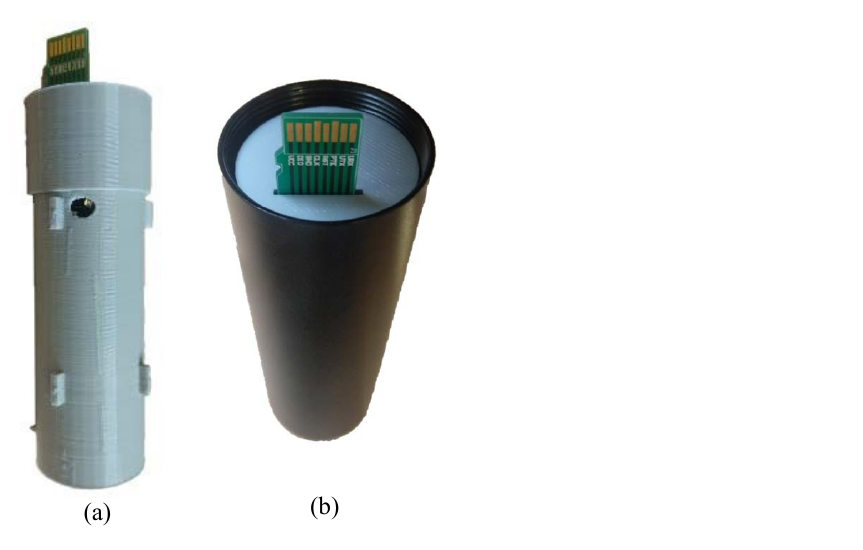
Figure 11. Underwater sensor node construction details: ( a ) PLA holder for node capsule with the main board and battery, and ( b ) holder inside of the